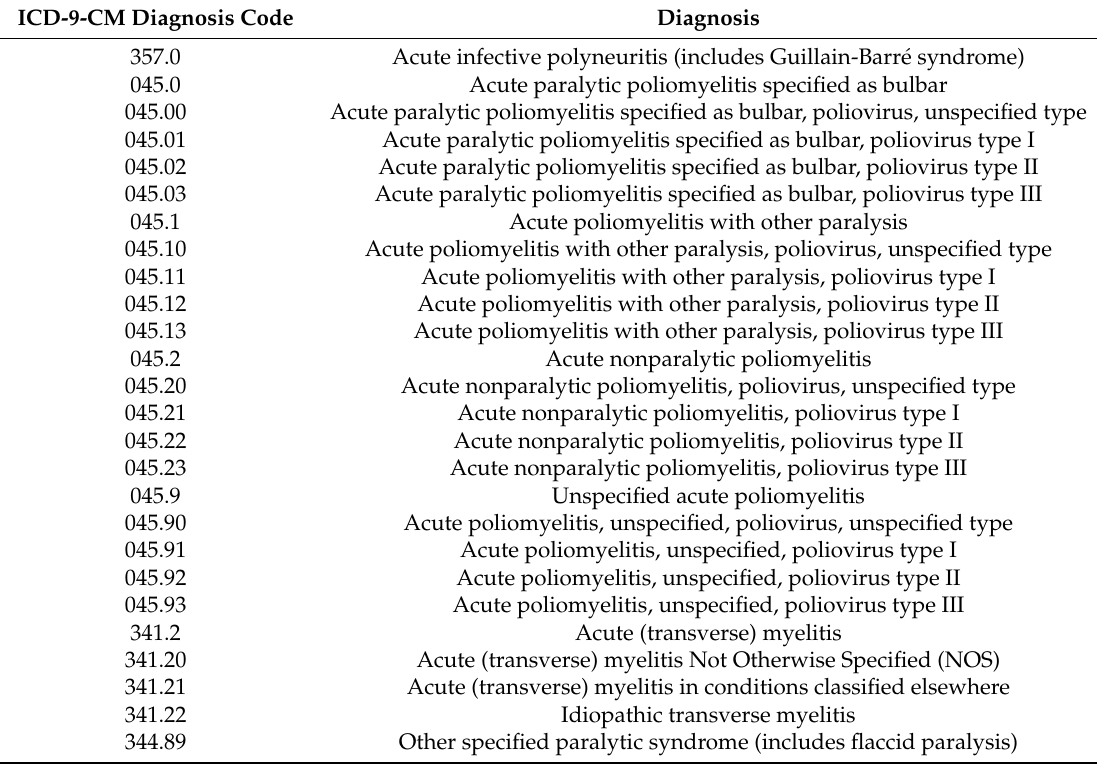
Table A1. List of diagnostic ICD-9 codes compatible with diagnosis of